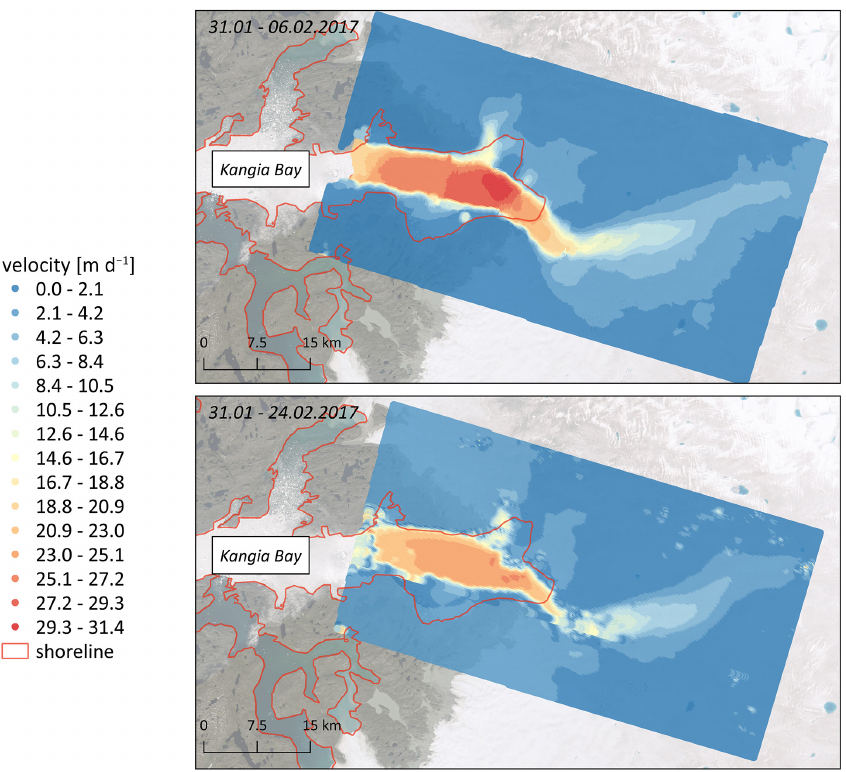
Fig. 4. Velocities for winter 2017 obtained from short and long intervals.